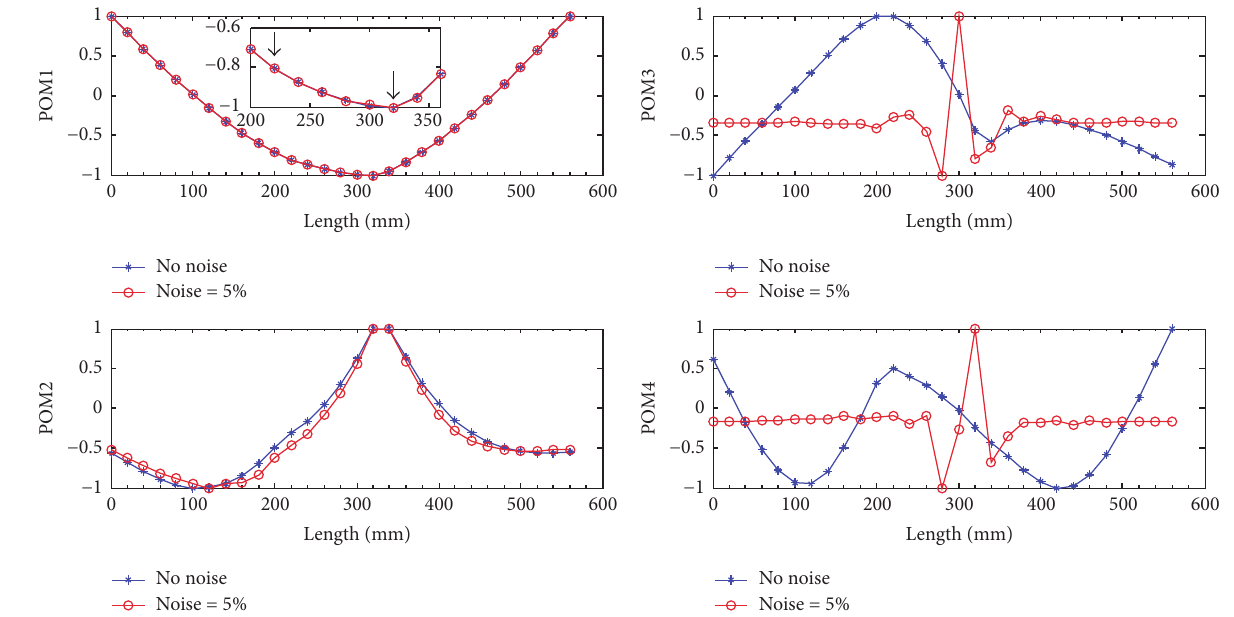
Figure 7: The first four POMs of double-cracked rotor in case